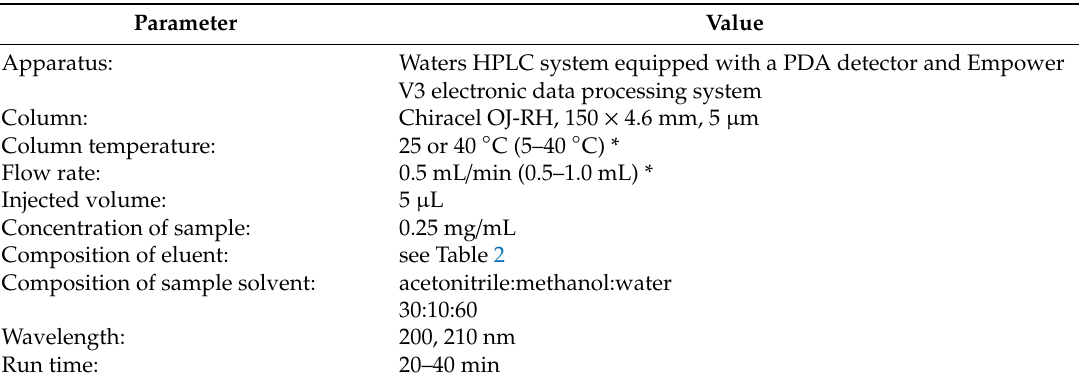
Table 1. Reversed phase HPLC